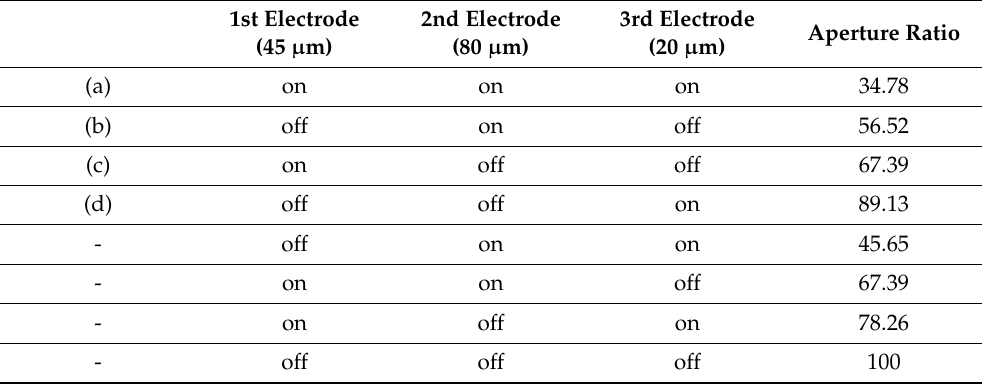
Figure 8. Optical properties of E-paper: ( a ) color reflectance; ( b ) transmittance measurement. Table 1. Aperture ratio of the fabricated E-paper under different voltage application on the lower